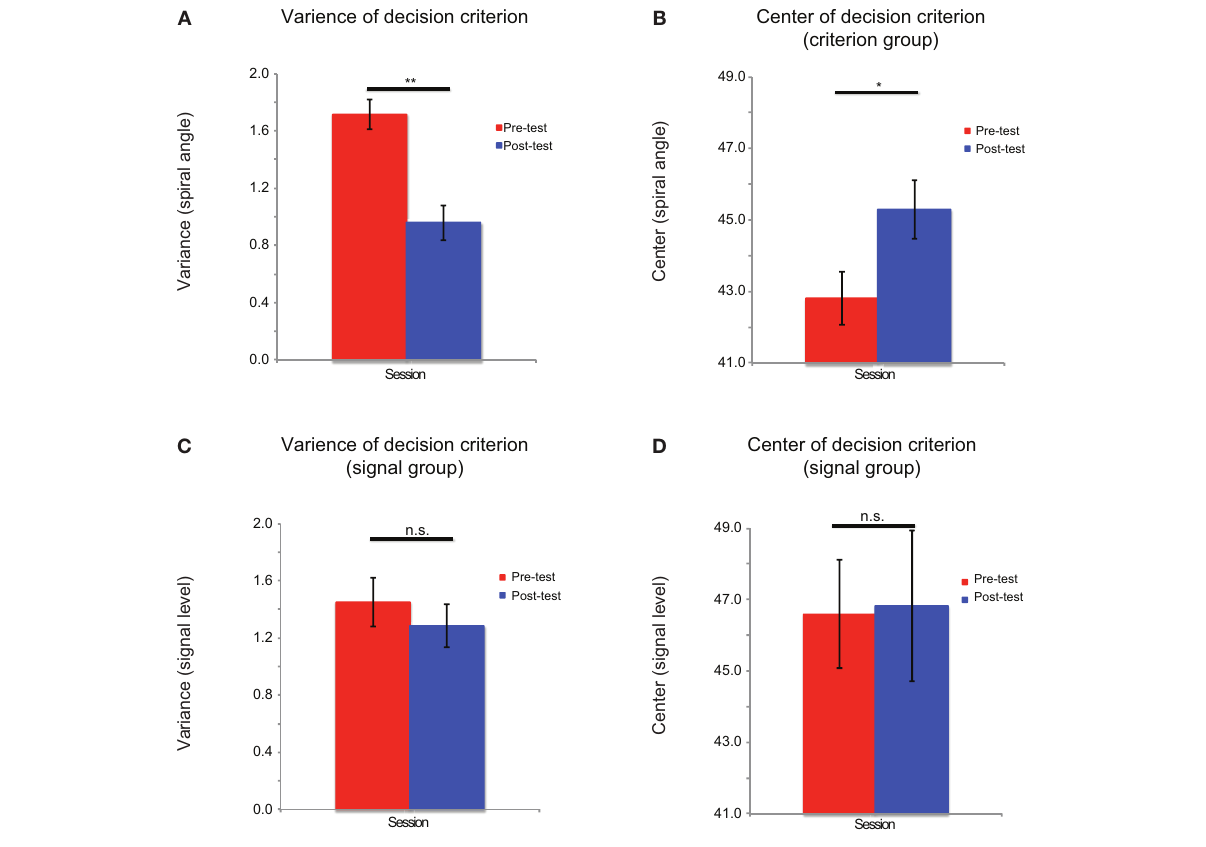
criterion comparison group, (C) the variance of the decision criterion distribution of signal detection group, and (D) the mean of the decision criterion of the signal detection group. Error bars represent the standard errors of the means. ∗∗ p < 0 . 01; ∗ p < 0 . 05; n.s.: not